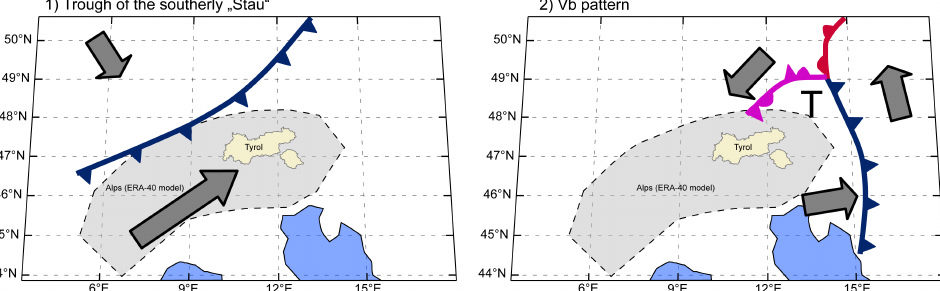
Fig. 3. Generalized synoptic patterns of (1) the trough of the “southerly Stau” and (2) the Vb pattern. The simple representation of the European Alps is based on the model of the Alps from the reanalysis project ERA-40 (adapted and modified according to Giardono, 2007).